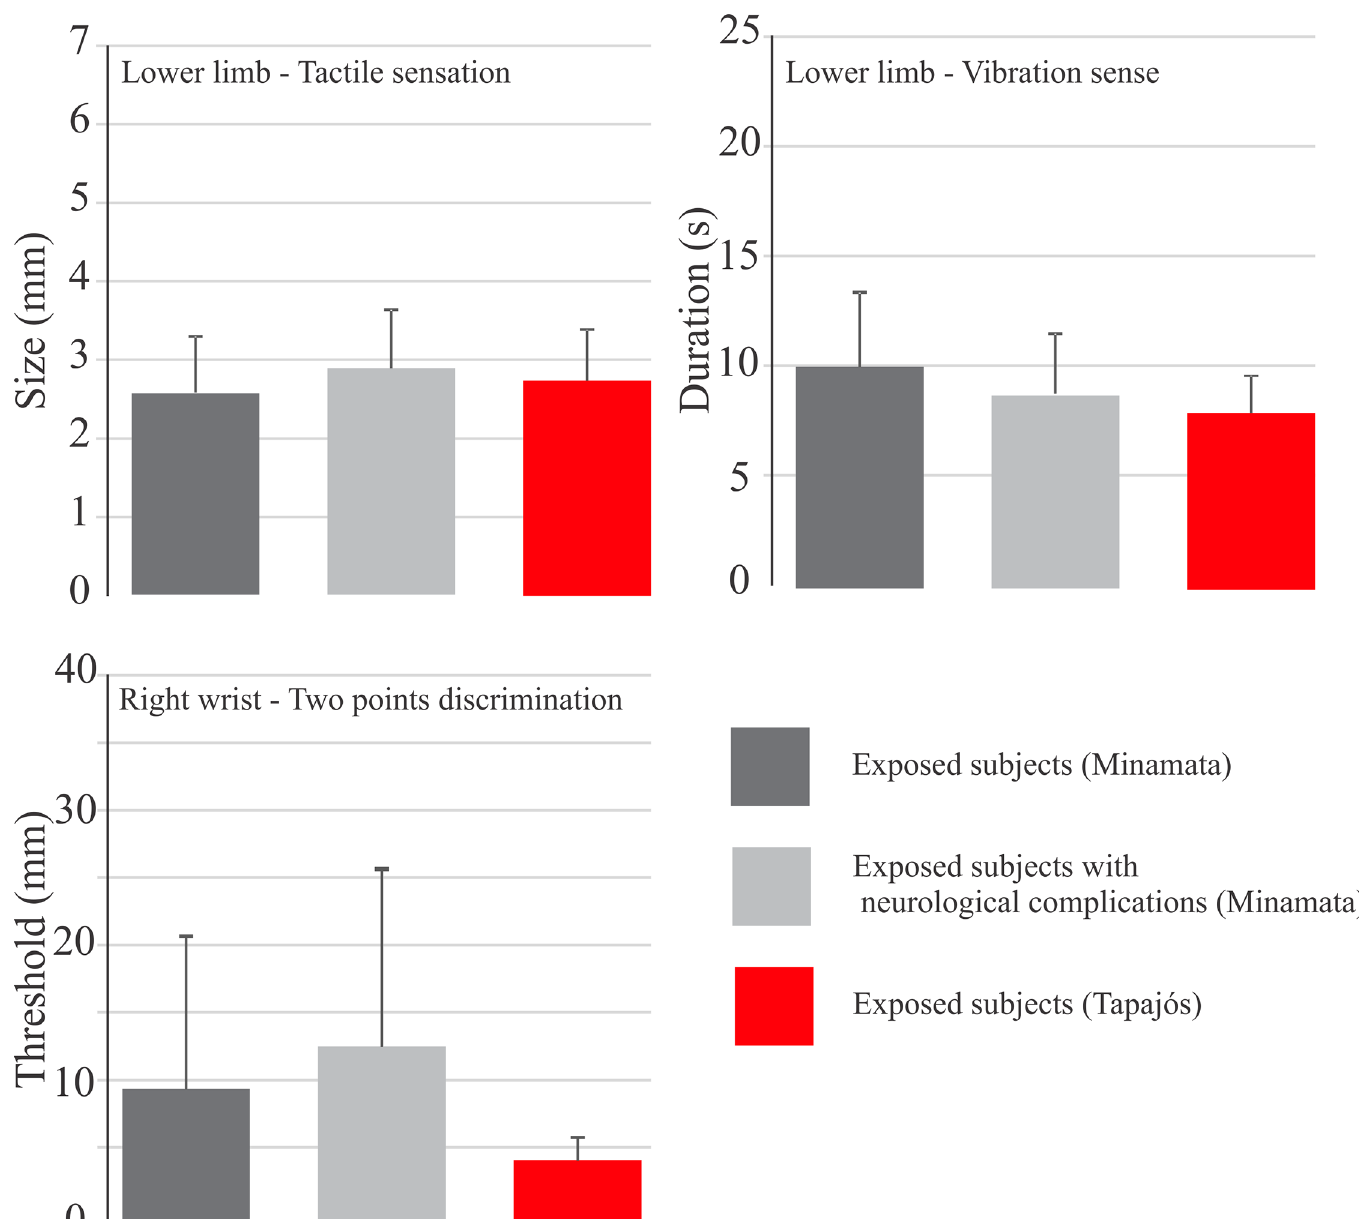
Fig 7. Comparison between somatossensory findings in Minamata and Tapajós. Comparison of the results of three different measurements – tactile sensation thresholds, vibration sensation durations, and two-points discrimination thresholds – obtained from mercury exposed subjects in the Minamata region (Japan) and Tapajós river basin (Brazilian Amazon). One body region for each measurement was chosen for illustration purposes. Minamata subjects were studied by Takaoka and colleagues [8] and divided in two groups: mercury-exposed subjects and mercury-exposed subjects with neurological complications. Tapajós subjects were studied in the current work and had no neurological complications as described for Minamata subjects. Tactile sensation thresholds in the lower limb was similar in the three groups. Vibration sensation durations were lower in the Tapajós subjects than in the Minamata subjects without neurological complications. Two-points discrimination thresholds in the right wrist were much higher with larger variability in Minamata subjects when compared with Tapajós subjects.